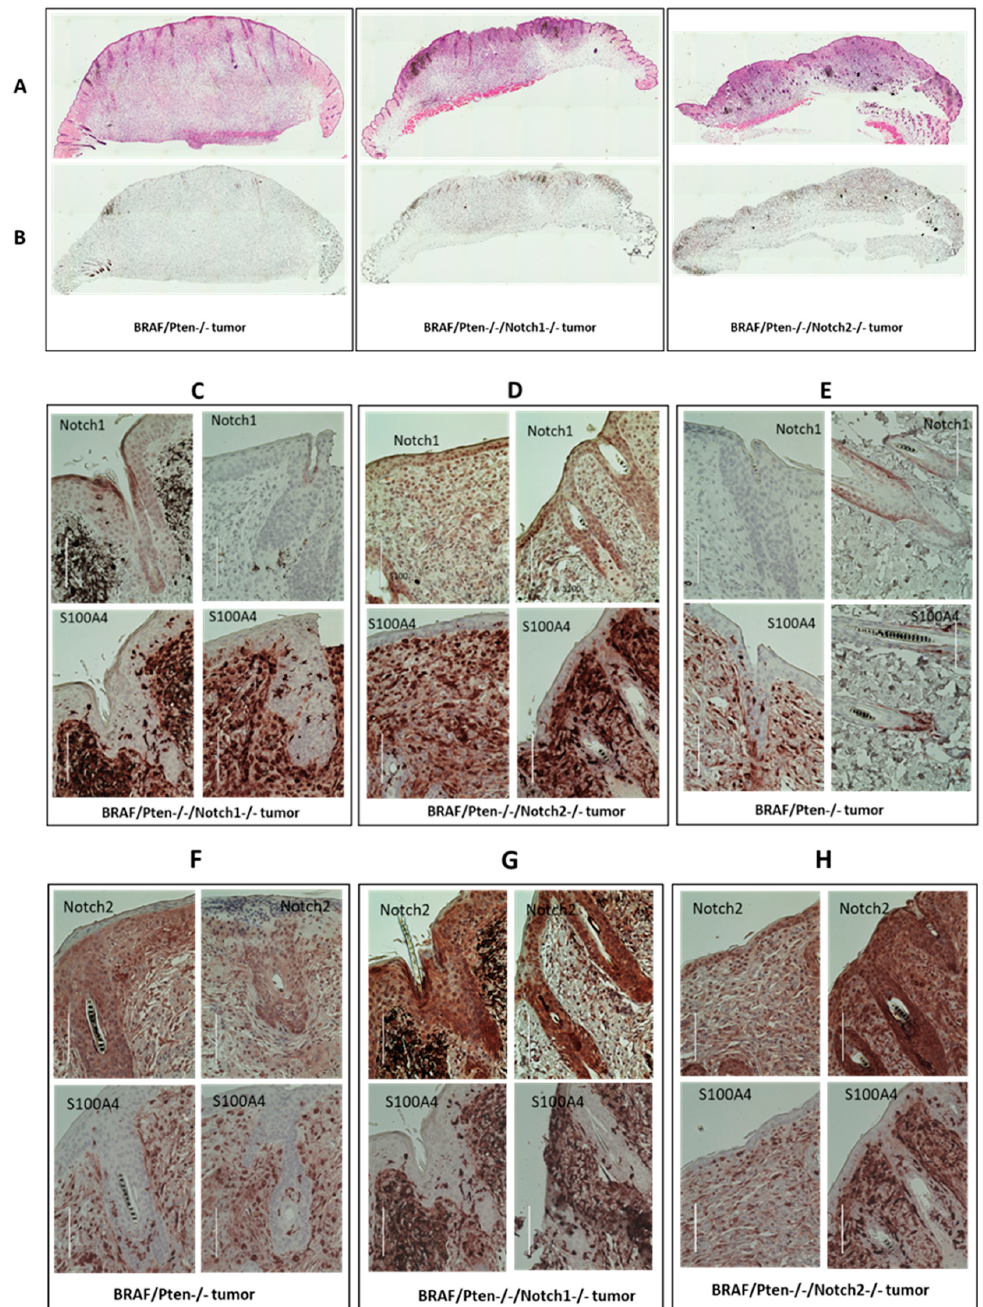
Figure 2. Histological and immunohistochemical analyses for tumors from BP (BrafCa/+/Pten-/-), BPN1(BrafCa/+/Pten-/-/Notch1-/-) and BPN2 (BrafCa/+/Pten-/-/Notch2-/-) mice. ( A ) H&E staining for the three different types of tumors. ( B ) Immunohistochemical staining with Ki67 antibody. ( C – E ) Immunohistochemical staining with Notch1 and S100A4 antibodies. ( F – H ). Immunohistochemical staining with Notch2 and S100A4 antibodies. Scale bar equals 100 µm.